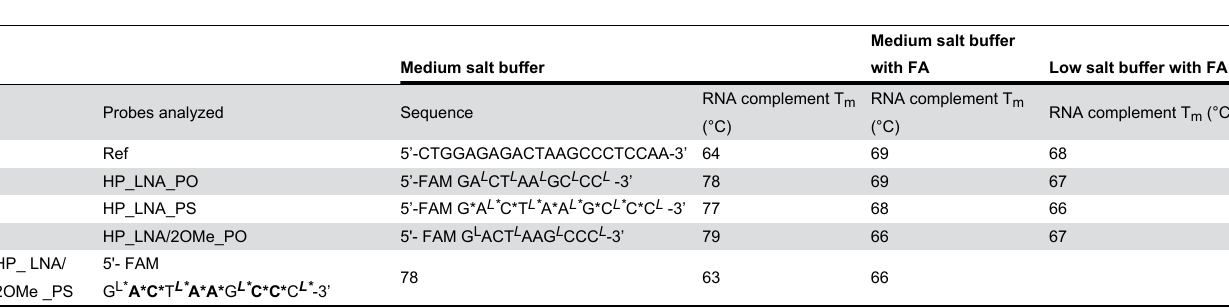
The DNA oligonucleotide probe reference (Ref) has the following sequence: 5’-CTGGAGAGACTAAGCCCTCCAA-3’. The RNA complementary oligonucleotide has the following sequence: 5’-UUGGAGGGCUUAGUCUCUCCAG-3’. LNA nucleotide monomers are represented with L superscript, 2’-OMe-RNA monomers in boldface letters, DNA nucleotides in capital letters, and phosphorothioate linkages by the symbol*, FAM- Fluorescein, FA- Formamide. doi: